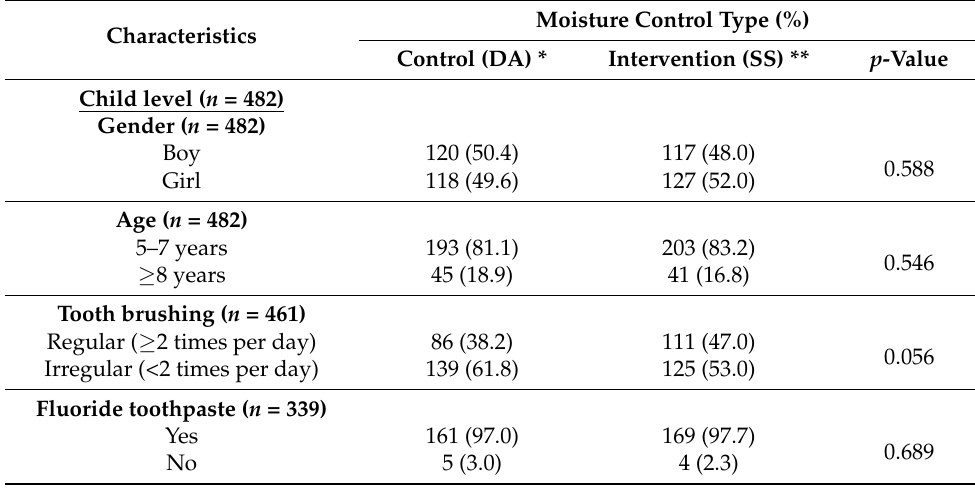
Figure 4. CONSORT Flow diagram. Table 1. Baseline characteristics of all cases (482 children and 672 teeth) by groups.